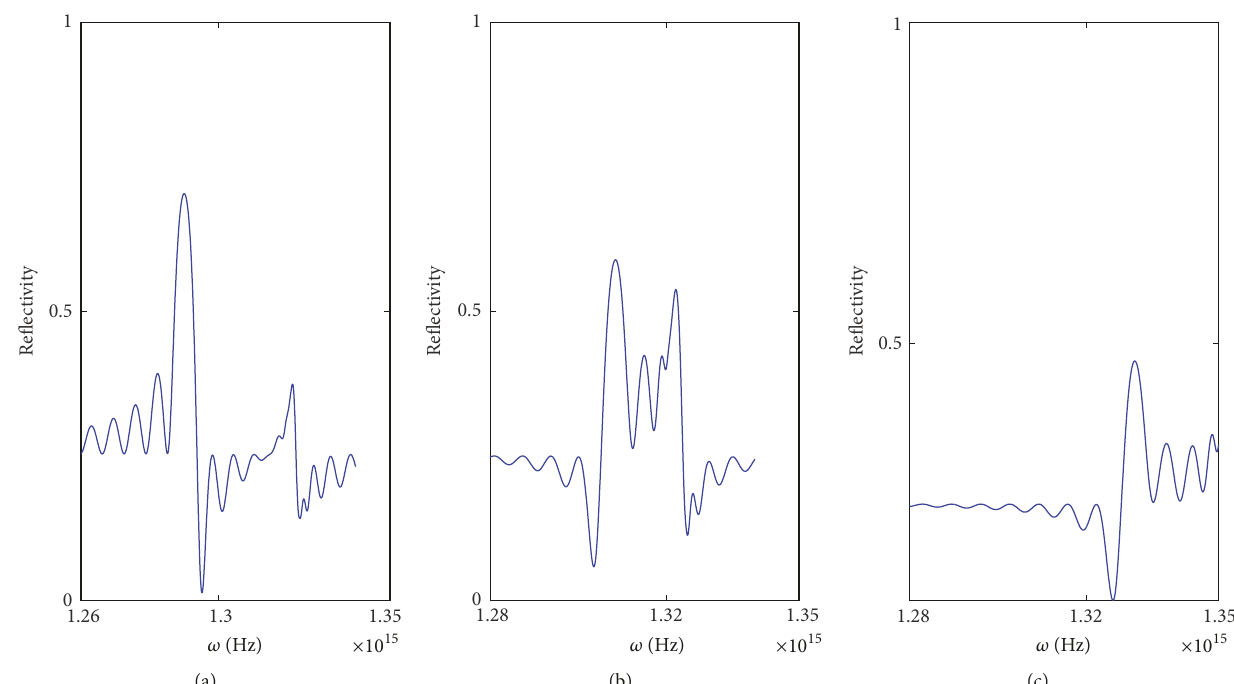
Figure 3: Reflectivity of 200-periodic QWs with presence of a strong pump pulse for (a) In 𝑥 Ga 1−𝑥 As/InP, (b) In 𝑥 Ga 1−𝑥 As/GaAs, and (c) In 𝑥 Al 1−𝑥 As/InP.